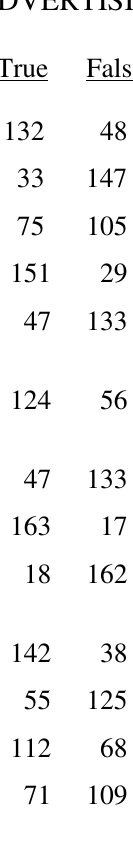
ITEMS REFLECTING AN ATTITUDE ON THE NECESSITY OF